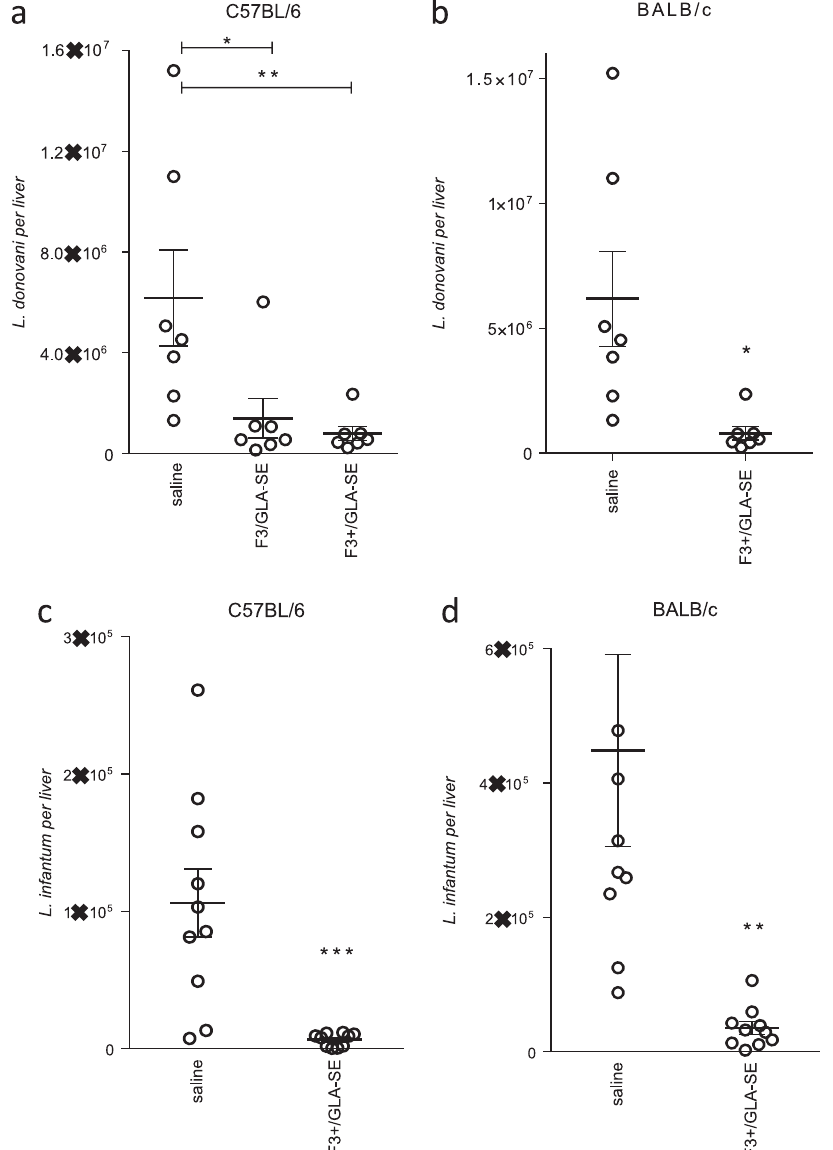
Fig. 4 Immunization with LEISH-F3+ reduces Leishmania infection. Mice were subcutaneously injected a total of three times with 5 μ g protein formulated with GLA-SE, then 1 month after the fi nal immunization were infected by intravenous injection of Leishmania spp. promastigotes. Livers were removed 1 month after inoculation and parasite burdens were determined by qPCR. In a and b , C57BL/6 and BALB/c mice, respectively, were infected with L. donovani . In c and d , C57BL/6 and BALB/c mice, respectively, were infected with L. infantum . Each point represents the burden of each individual mouse, with the bars indicating the mean and s.e.m for each group with 7 – 10 mice per group. Data are representative of results obtained with each protein in 2 – 3 independent